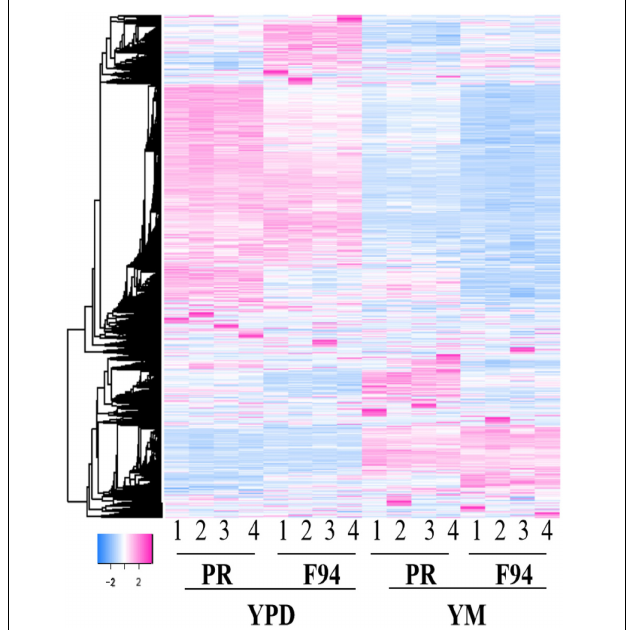
FIGURE 3 | Differential gene cluster map. The heatmap of the enrichment of the differentially expressed genes of F94 compared with the wild strain PR and the strains under the Yeast Malt Agar (YM) treatment compared with the YPD. The enrichment illustrates good four repetitions. The legend of the color bar displays the log2 values of the fold change of each replicate of each gene, from –2 to